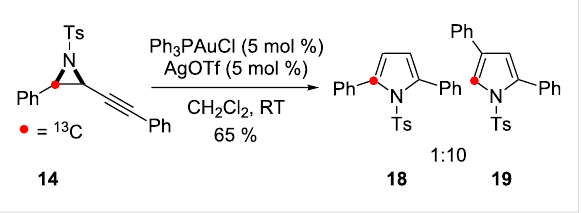
Scheme 9: Cycloisomerisation of 14 in the skeletal rearrangement